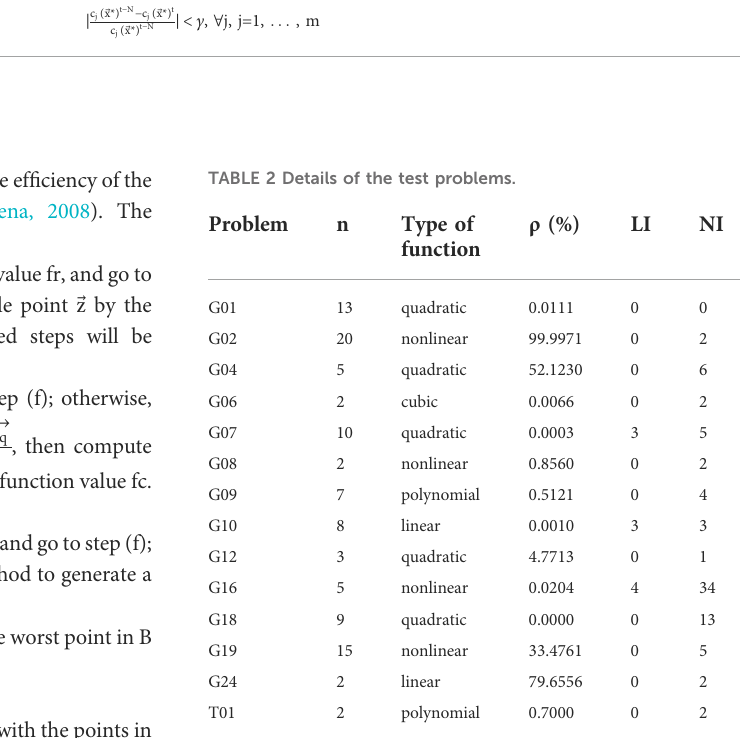
TABLE 1 Termination criteria for the algorithms. Iteration criterion Stop when reaching the maximum number of iterations Convergence criterion